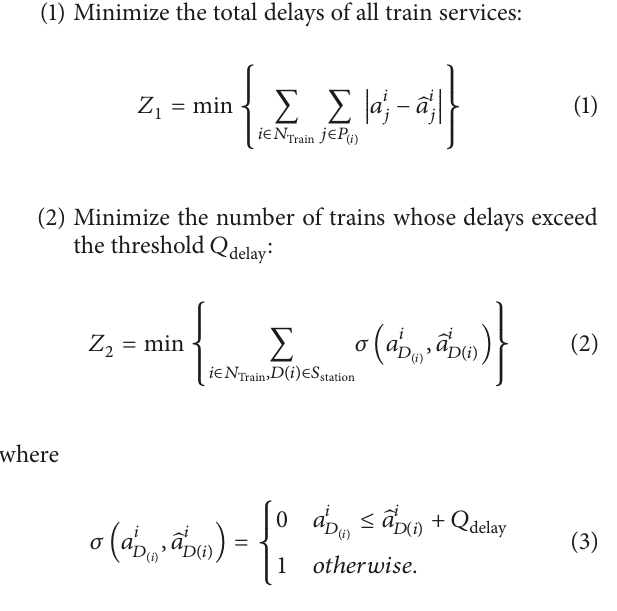
scheduled arrival time of 𝑡 1 is earlier than that of 𝑡 2 . However, if train service 𝑡 1 arrives late at station B, train service 𝑡 2 will also be delayed because that train services 𝑡 1 and 𝑡 2 occupy the same siding of station B in sequence. The primary delays of train service 𝑡 1 propagate to train service 𝑡 2